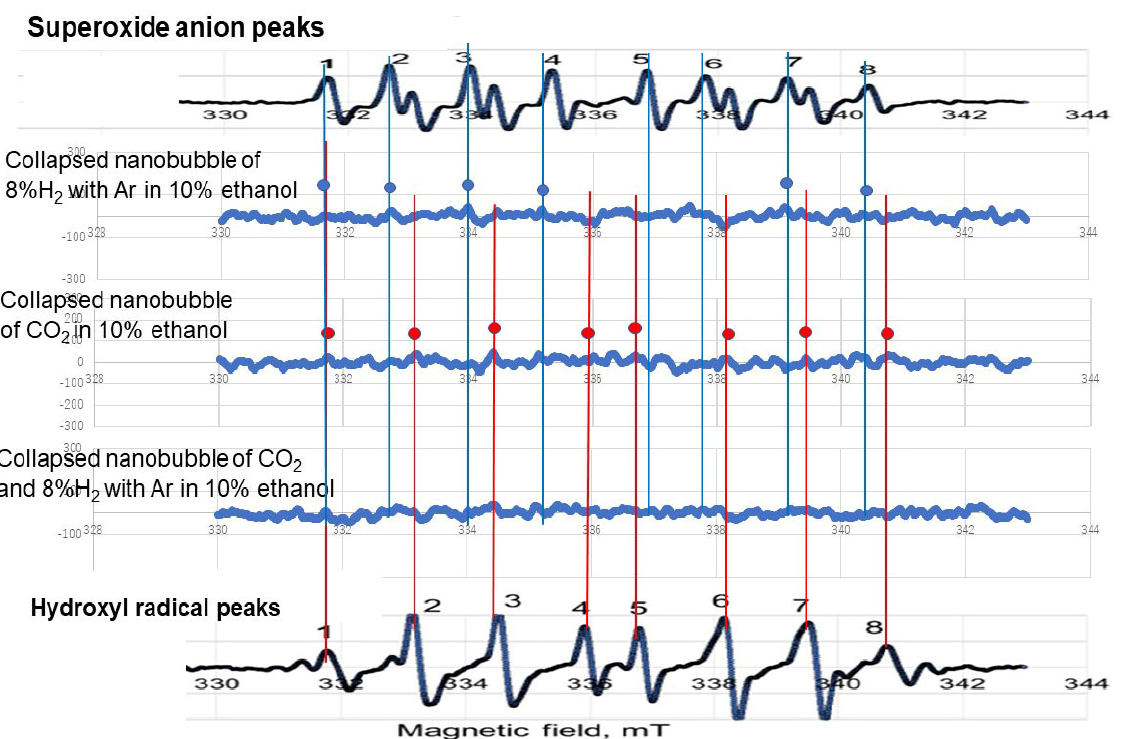
Figure 9. Radical observation by changing pH from 9 to 5 of three kinds of gas nanobubbles (i.e., 8% H 2 in Ar, CO 2 , and CO 2 after 8% H 2 in Ar) in 10 vol.% ethanol aqueous solution mixture.